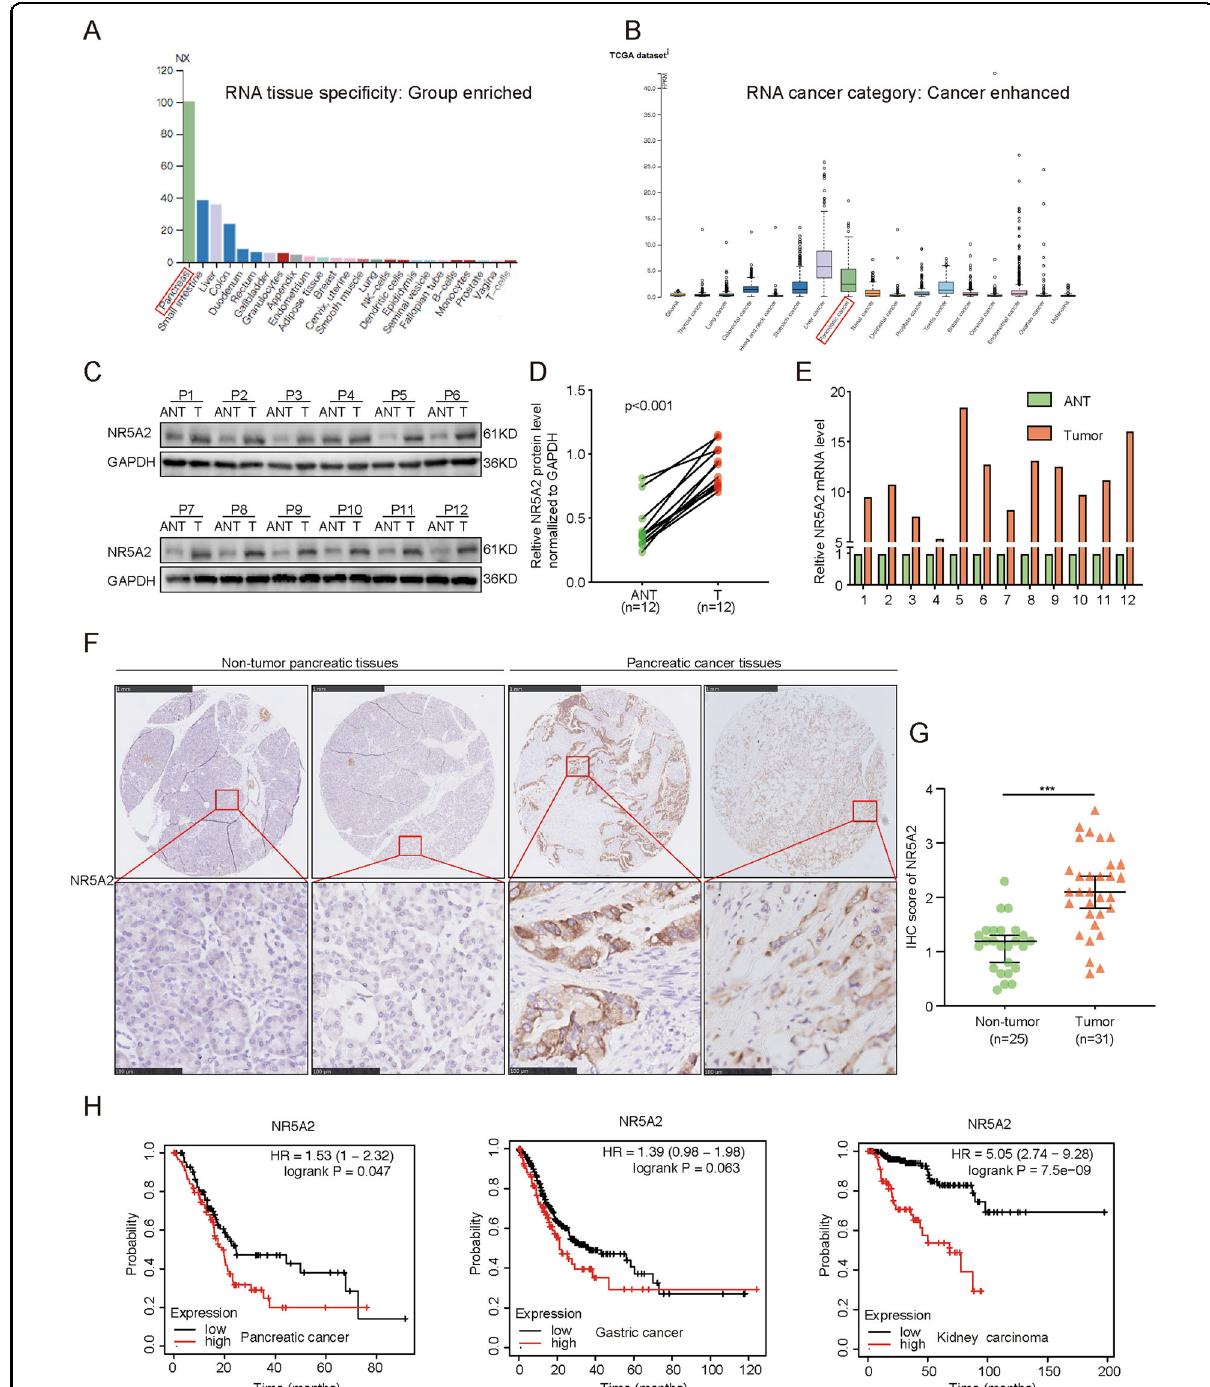
Fig. 1 The overexpression of NR5A2 is correlated with unfavorable prognosis in malignant tumors. A HPA database was searched for NR5A2 mRNA expression in different normal tissues. B HPA database was searched for NR5A2 mRNA expression in different tumor tissues. C , D . Western blot analysis for the expression of NR5A2 in 12 paired primary PDAC tissues (T) and the matched adjacent normal tissues (ANT) of the same patient ( C ). The protein expression level of NR5A2 were quanti fi ed by ImageJ software ( D ). GAPDH served as an internal reference. p < 0.001, paired t test. E RT- qPCR analysis for the expression of NR5A2 in 12 paired primary PDAC tissues (T) and the matched adjacent normal tissues (ANT) of the same patient. GAPDH served as an internal reference. F , G IHC Images ( F ) and dot plots ( G ) of NR5A2 staining using TMA tissue sections (normal pancreatic specimens: n = 25, PDAC TMA specimens: n = 31, P < 0.001, unpaired t test). The scale bars were shown in the fi gure. H K – M plotter was used to analyze the effect of NR5A2 on the overall survival of pancreatic cancer, gastric cancer, and kidney